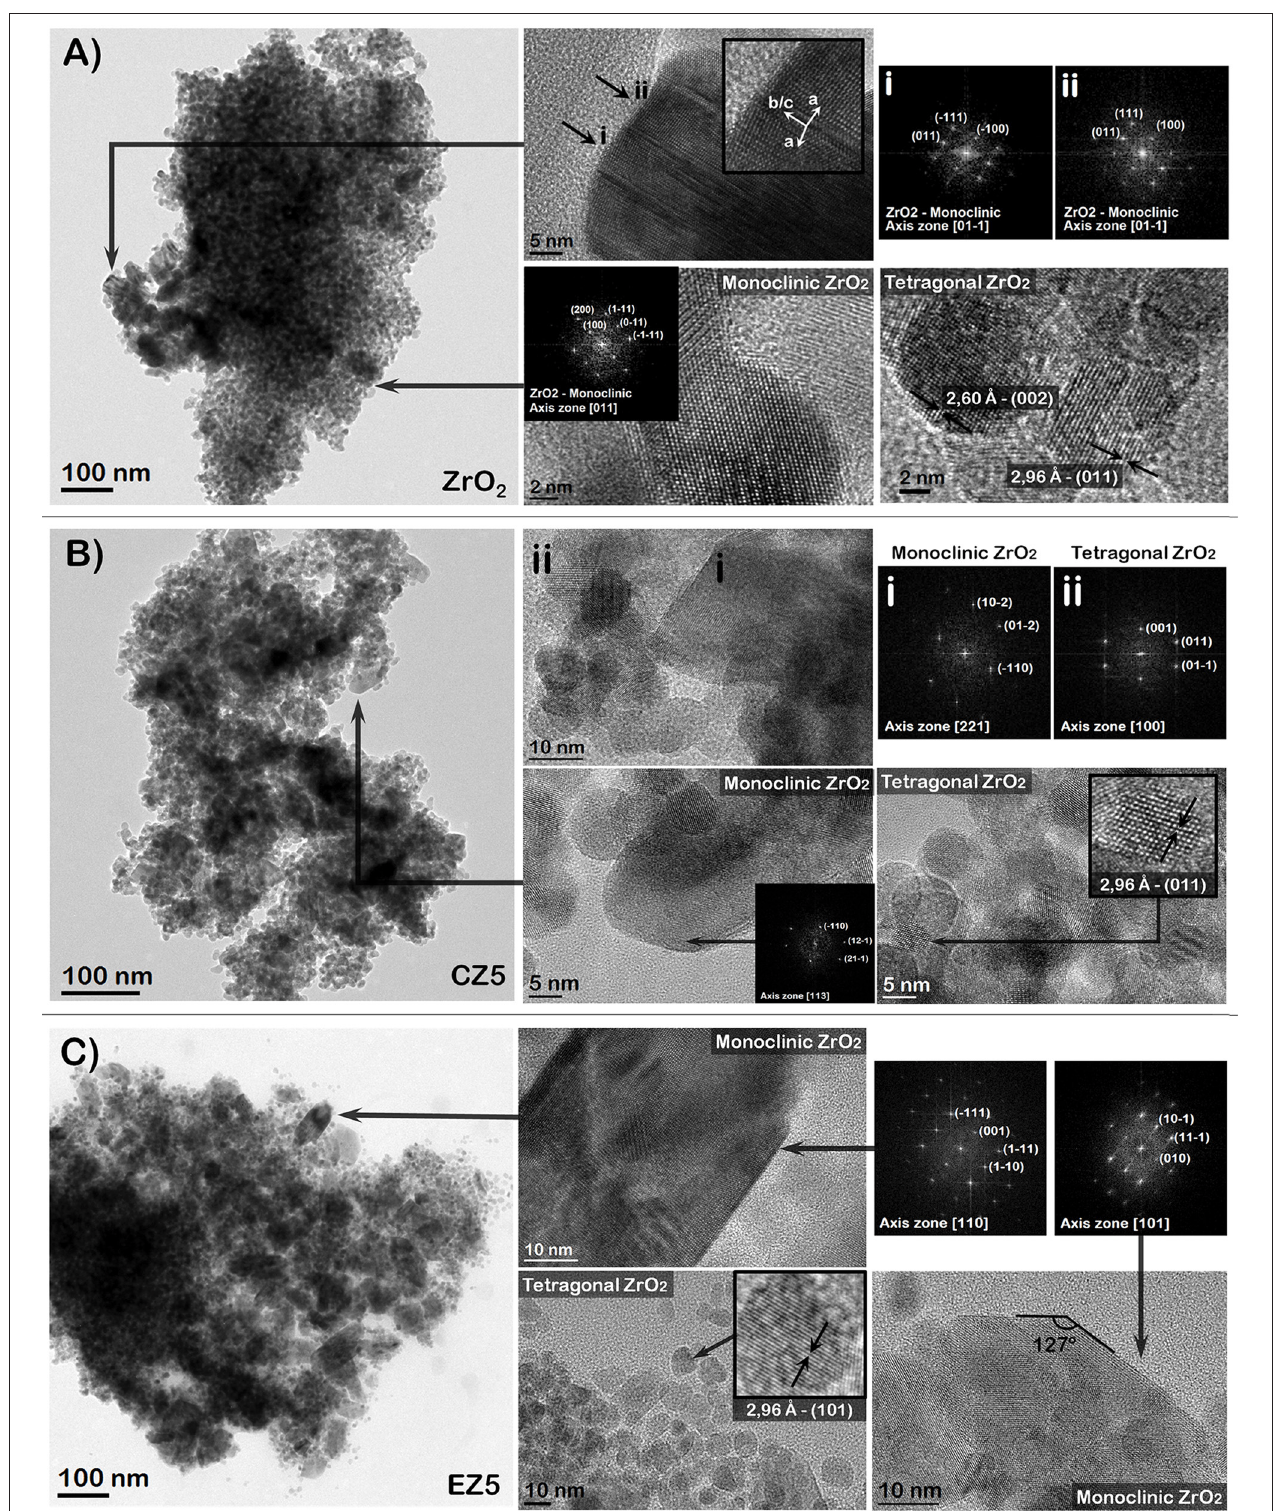
FIGURE 6 | TEM (left column) and HR-TEM (center and right columns) images of pure ZrO 2 (A) and RE-doped samples with 5mol % of Ce and Er: CZ5 (B) and EZ5 (C) , respectively.